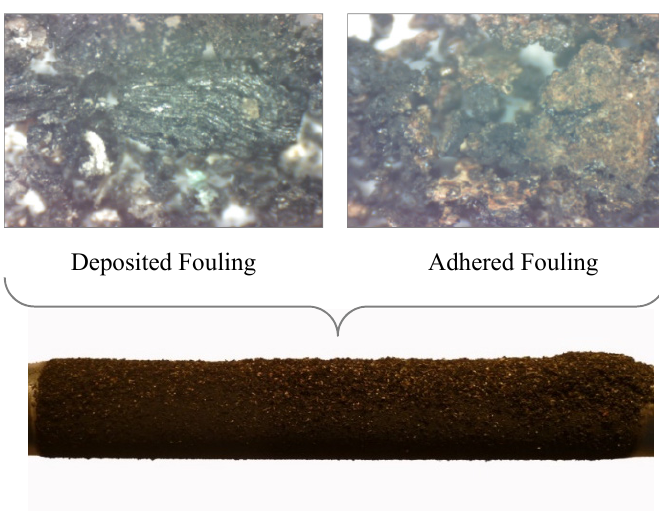
Figure 2. Picture of the two different types of fouling samples collected in each of the experiments carried out and appearance of the heat exchanger tube after